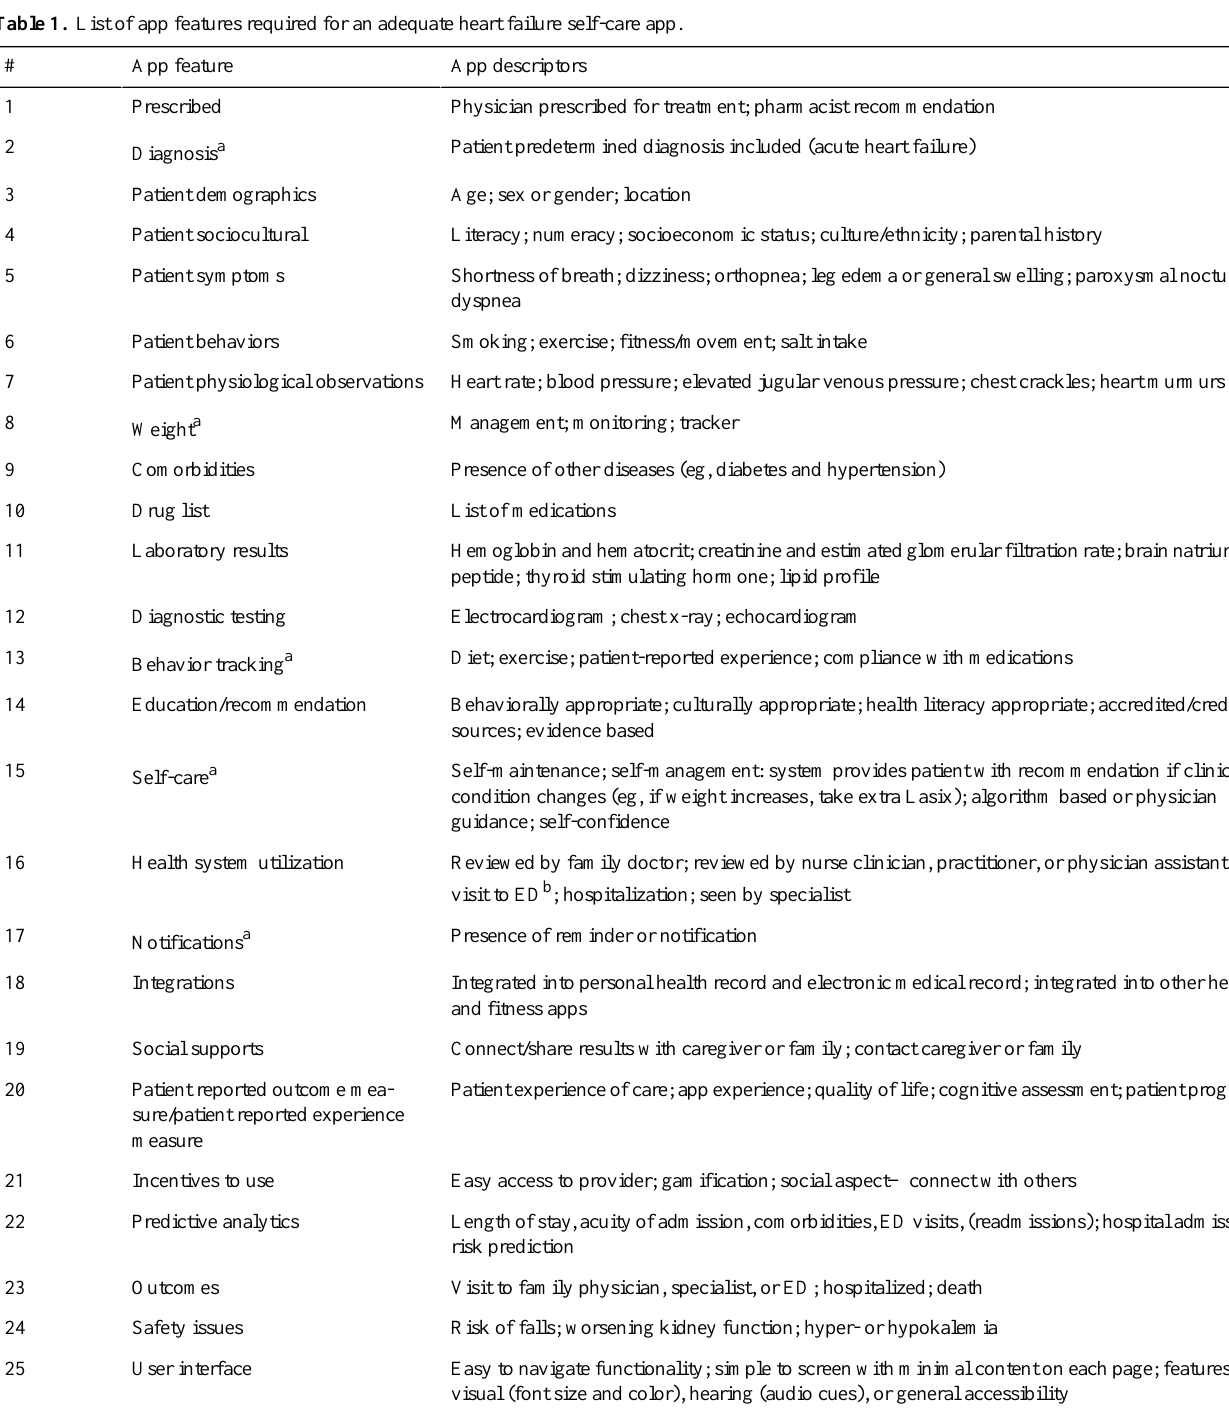
Table 1. List of app features required for an adequate heart failure self-care app.